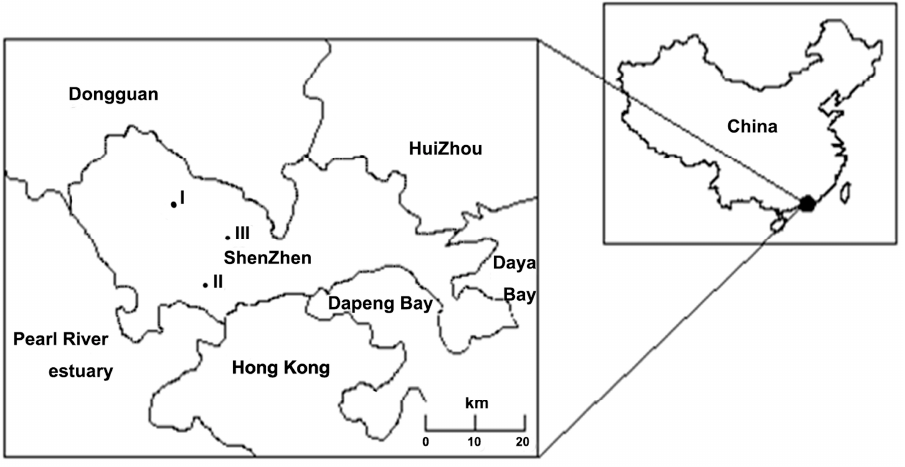
Figure 1. Location of the study area (I: Shi-yan Reservoir; II: Xi-keng Reservoir; III: Luo-tian Reservoir), and Shenzhen region (south of Guangdong Province).